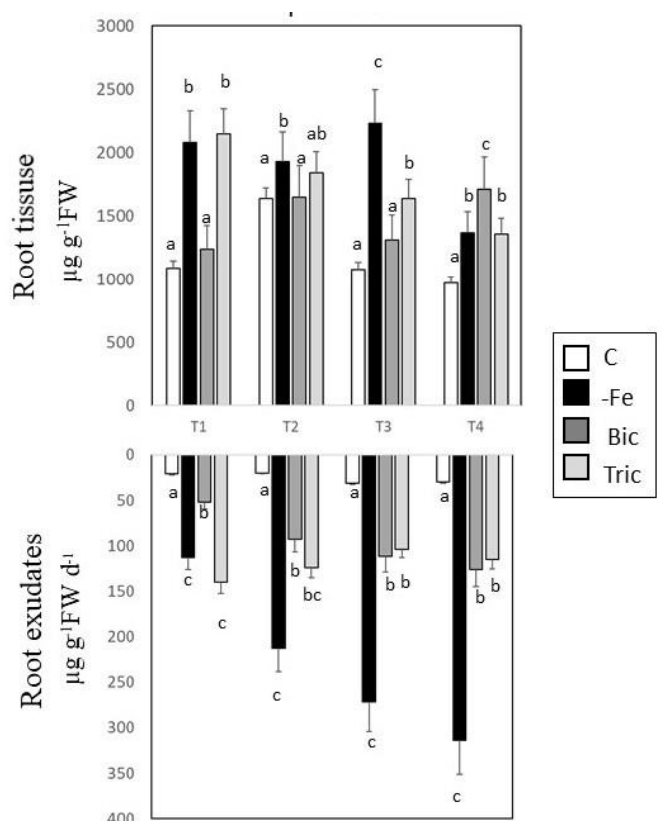
Figure 4. Contents of phenolic compounds in root tissues and exudates of plants grown in control conditions (C), direct iron deficiency conditions ( – Fe), and under induced Fe deficiency in the presence of bicarbonate (Bic) or alkaline organic buffer (Tric). T1, T2, T3, and T4 correspond to sampling at 1, 3, 5, and 7 days. Values are expressed as the means ± SE (standard error) ( n = 5). Different letters indicate statistical differences ( p < 0.05) within each treatment.